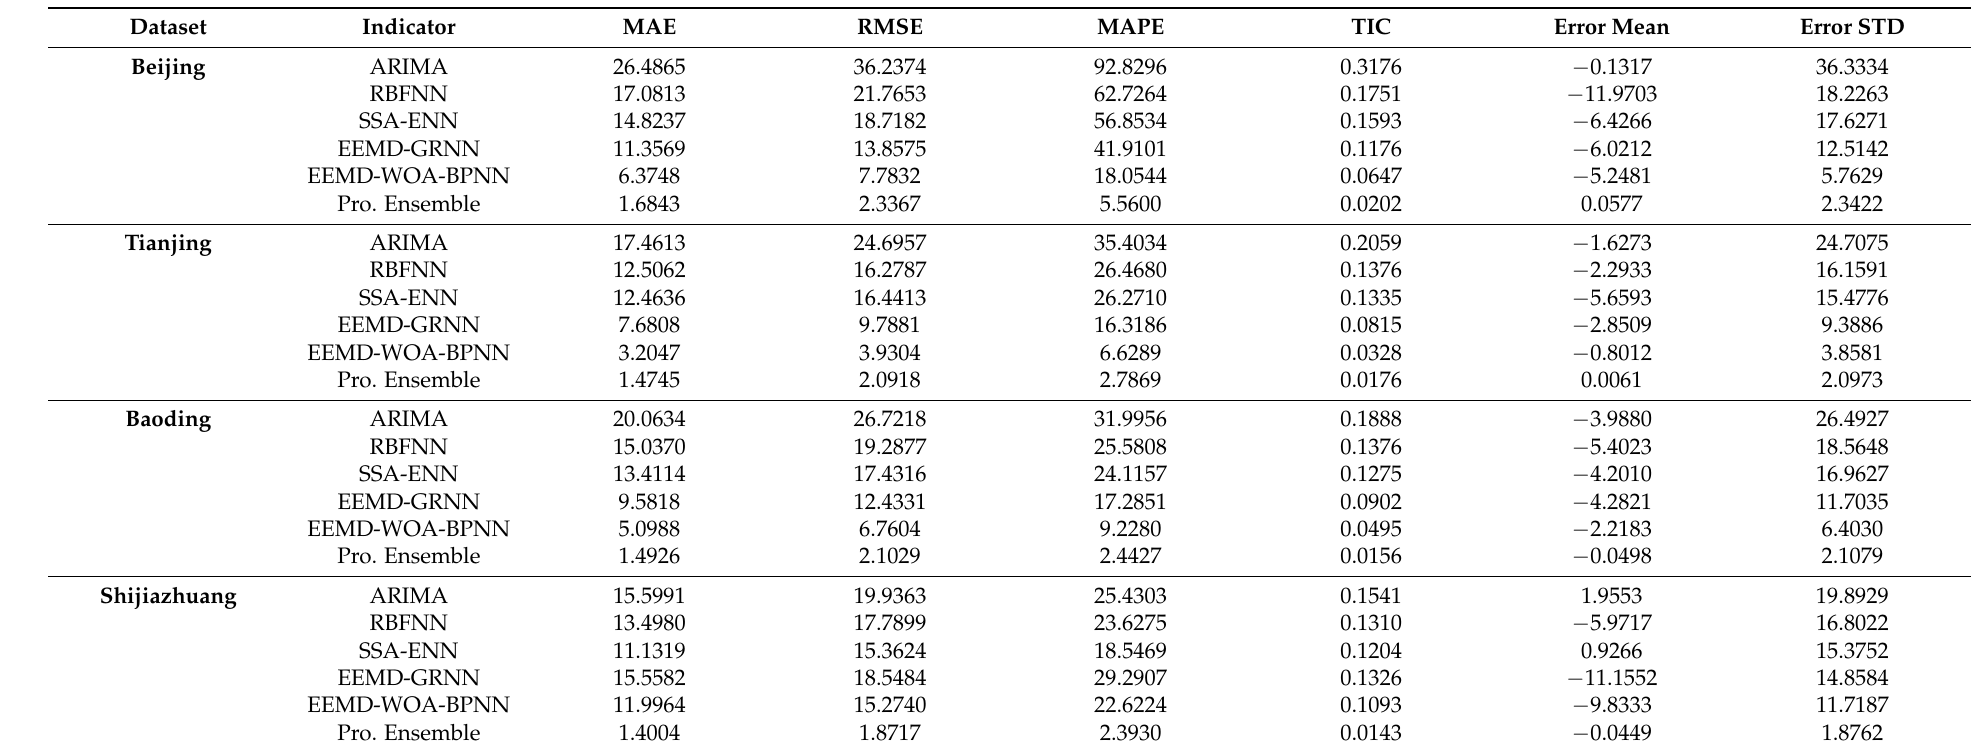
Table 6. Comparison of prediction performances with existing